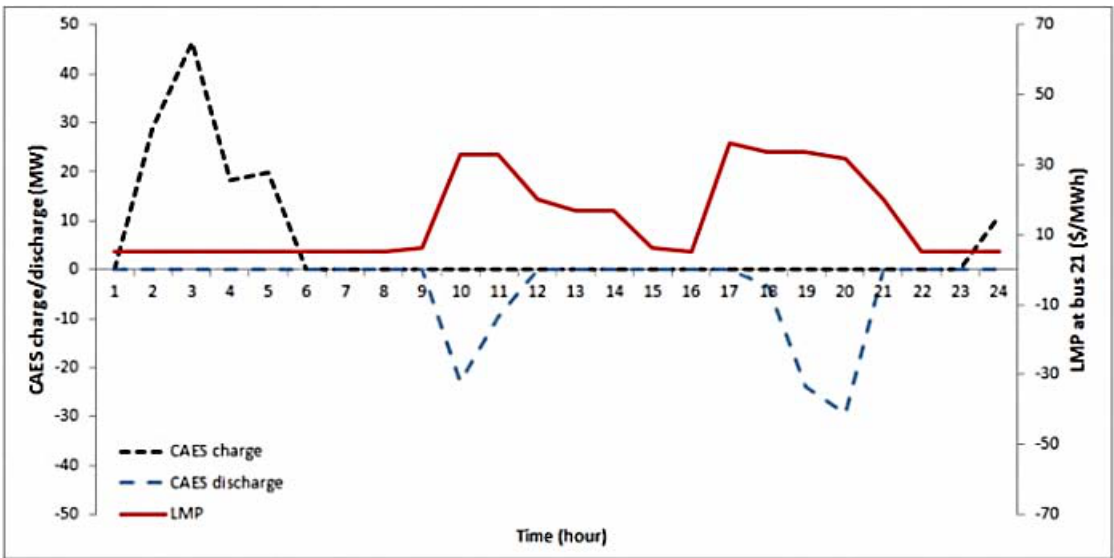
Figure 6. CAES DA charge/discharge schedule and DA LMPs at bus 21 under scenario